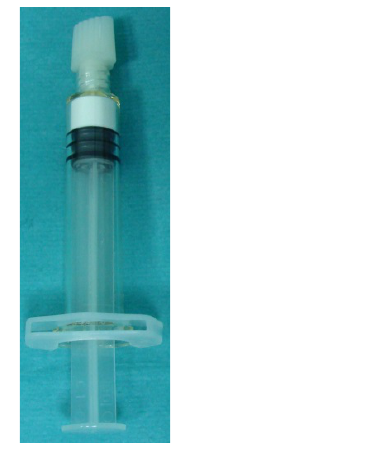
Figure 2. The “Defensive Antibacterial Coating ([DAC®] Novagenit Srl, Mezzolombardo, Italy) is a fast-resorbable hydrogel coating composed of covalently linked hyaluronan and poly-D,L-lactide. It is supplied in a prefilled syringe as a powder that is reconstituted at the time of surgery with a solution composed of sterile water for injection and antibiotic(s).